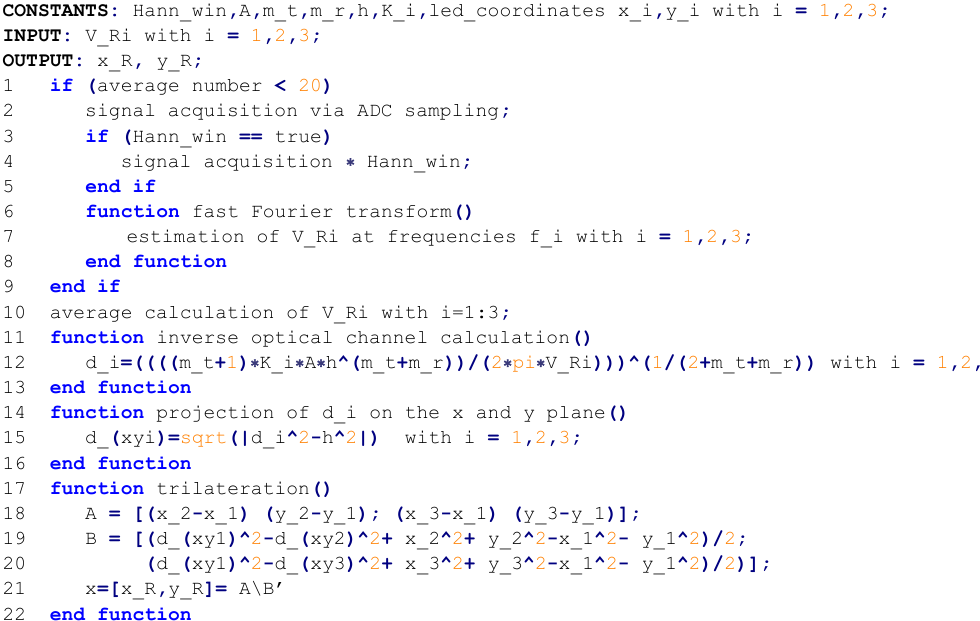
Figure 4. Pseudocode resuming the sequence of operations performed by the MCU to achieve the localization.